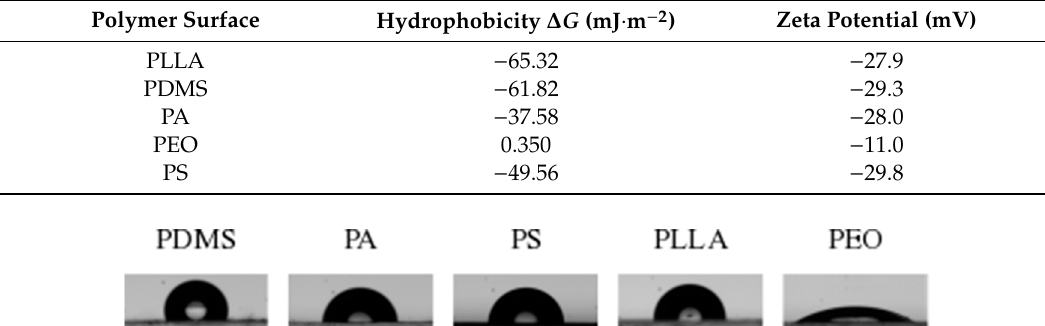
Table 3. Surface properties of different materials.